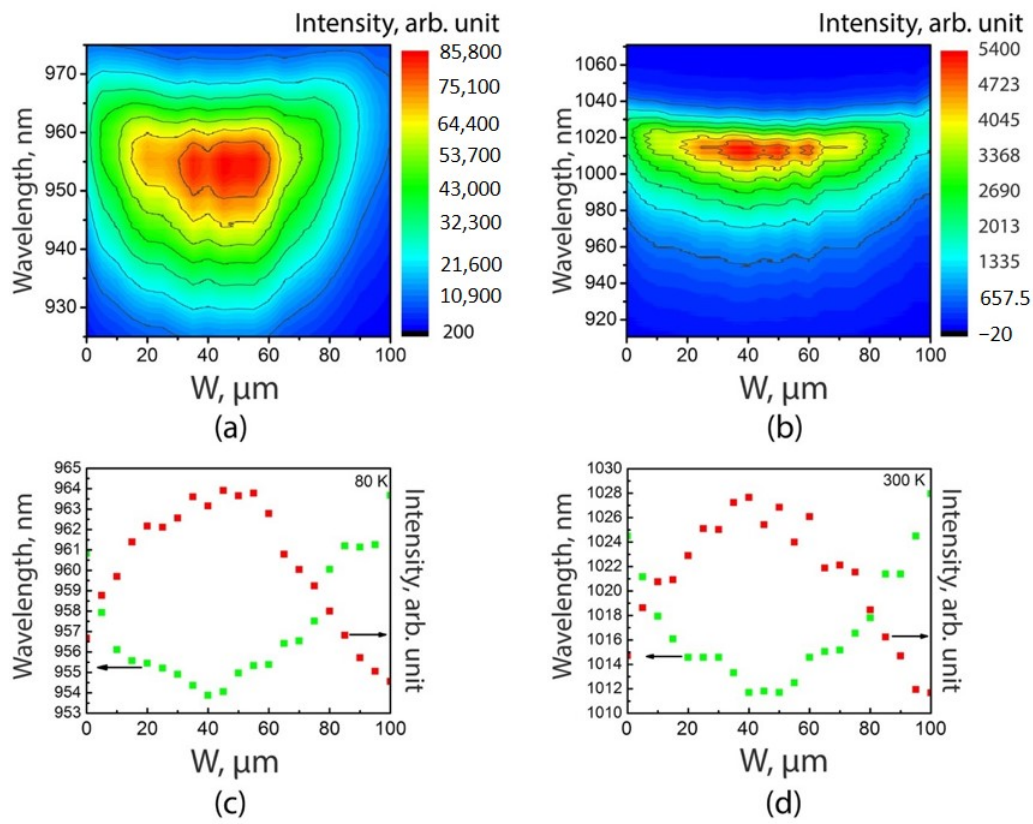
Figure 6. µ -PL spectra maps measured at 80 K ( a ) and 300 K ( b ) that show the spatial distribution of spectral position and intensity of the PL spectra of the InGaAs QW of the SAE-ML-W sample. PL spectra peaks and the corresponding wavelengths as functions of the position in the window obtained from µ -PL-maps measured at 80 K ( c ) and 300 K ( d ) for the SAE-ML-W sample. Green dot—wavelength, red dot—intensity.